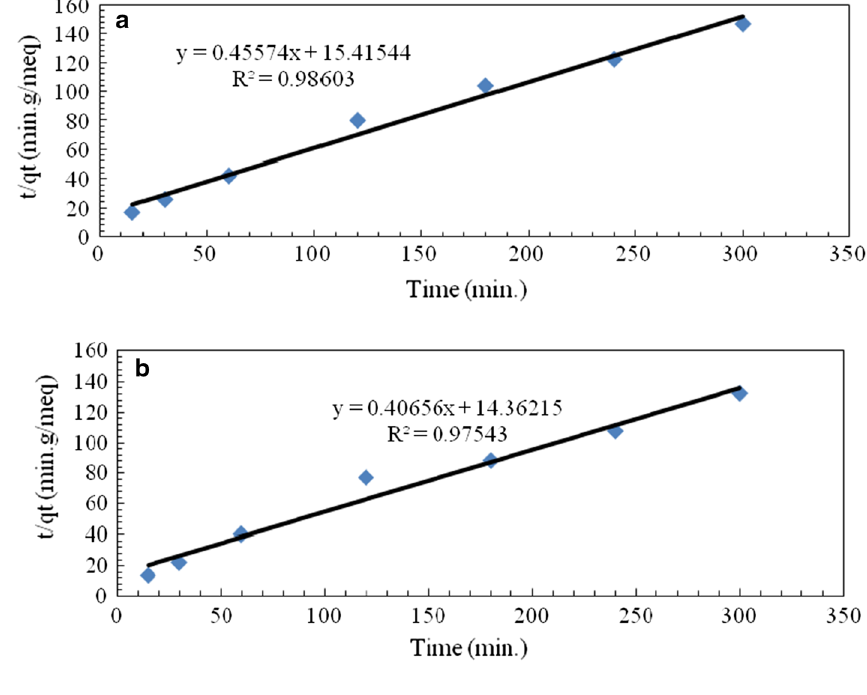
Fig. 8 a and b Pseudo-second- order modeling for chromium ions removal using 0.5 g/L of ACP-Zn, a and ACP-Zn-Fe b at pH 2.0—2.5 and 25 ± 0.2 °